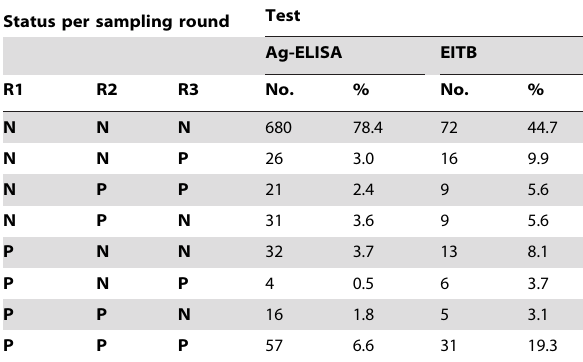
Table 3. Infection/exposure status changes based on sero- antigen and sero-antibody analysis throughout the study